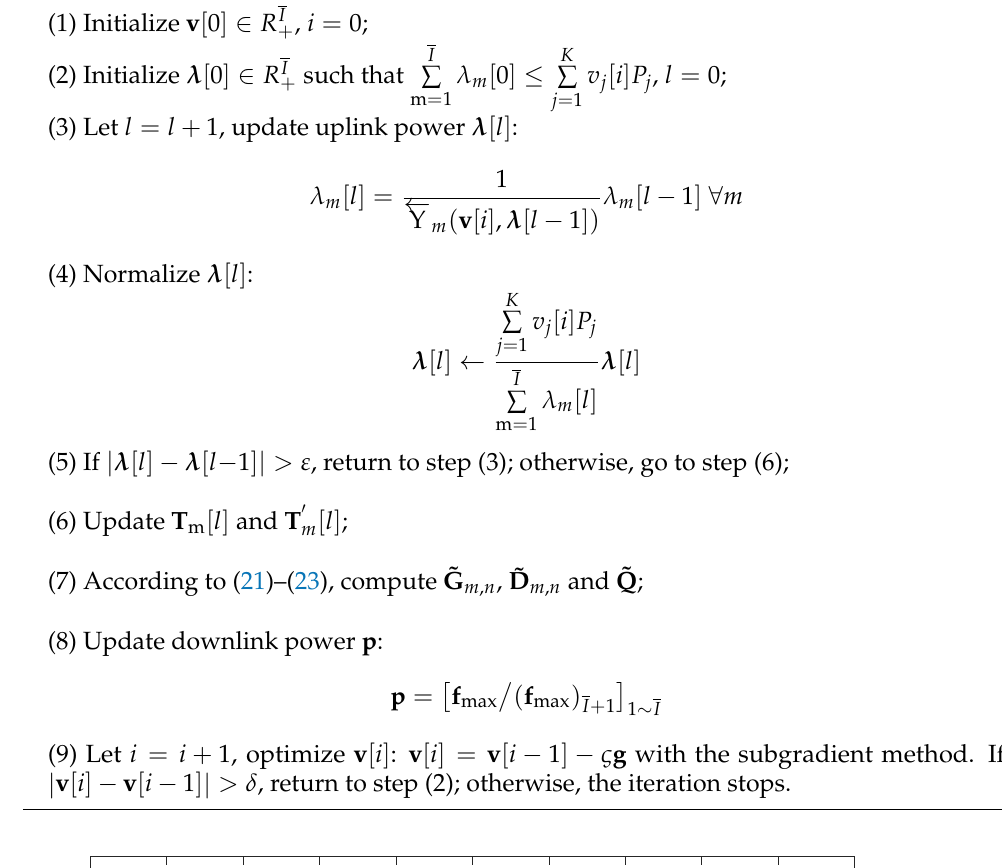
Algorithm 2 Power Allocation for Multi-Cell MU-MISO System